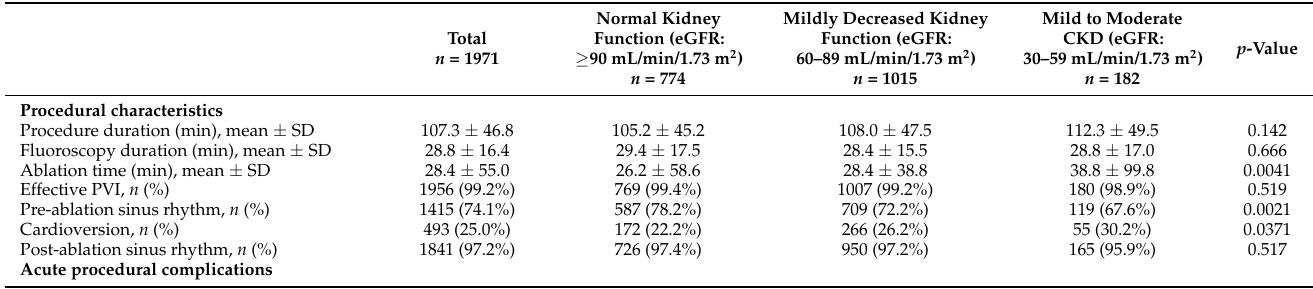
Table 2. Procedural characteristics and acute procedural